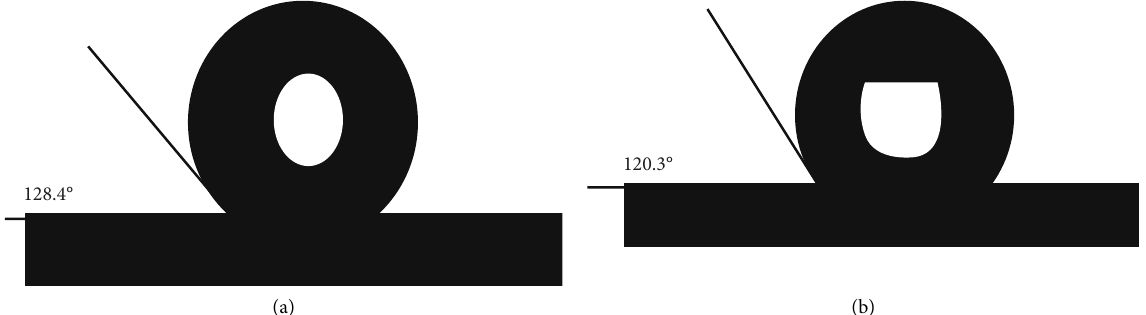
Figure 7: Contact angles of seawater droplets on (a) GO-MNP and (b) GD-MNP